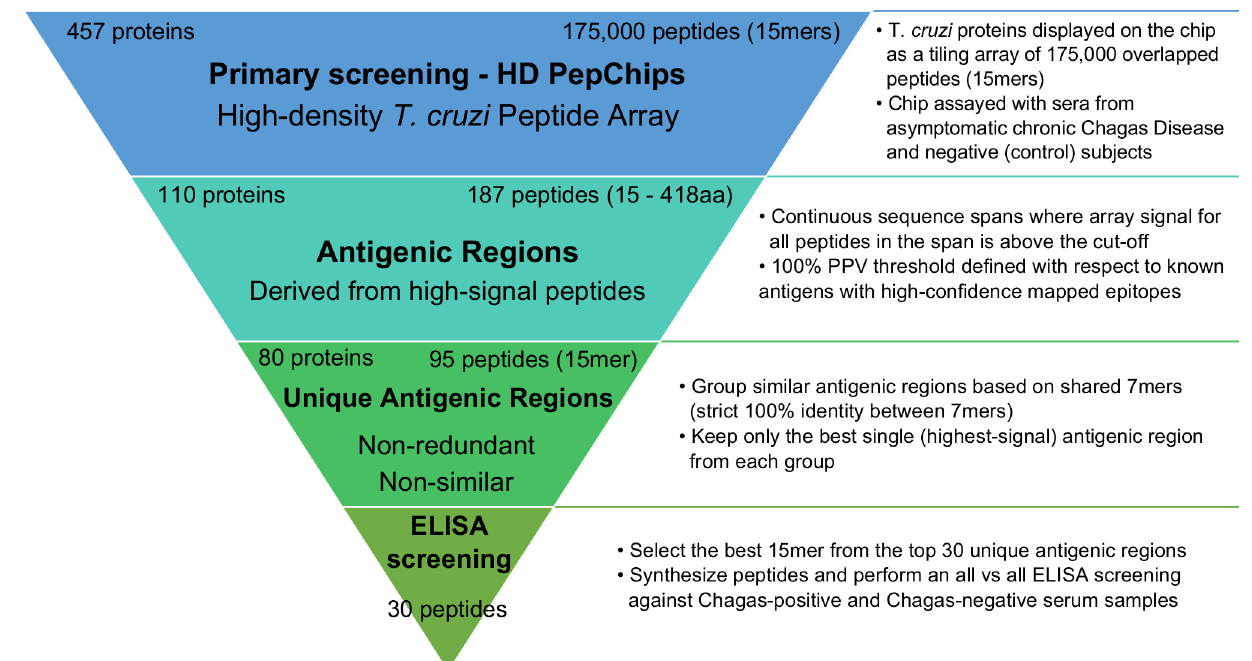
Fig 1. Flowchart showing the strategyfor peptide